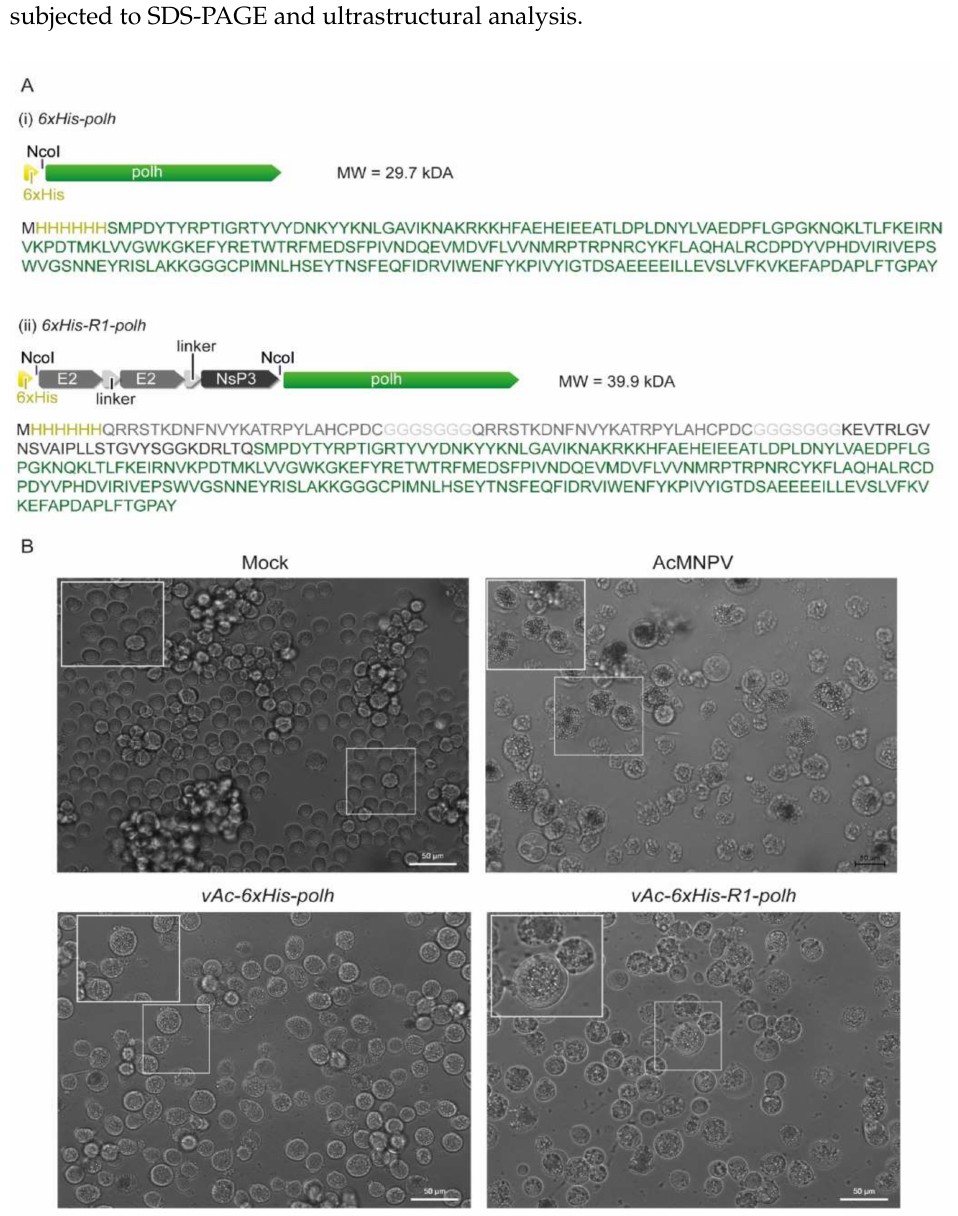
Figure 1. Schematic representation and light microscope of recombinants 6xHis-polh and 6xHis- R1-polh. ( A ) Schematic representation of modified polh gene cloned into pFastBac1 to generate 6xHis-polh and CHIKV multi-epitope gene (R1) fused at 5 (cid:48) region of polh (6xHis-R1-polh); ( B ) Sf9 cells at 72 h.p.i. with the respective second passage virus stock (m.o.i. of five): mock-infected cells, cells infected with vAc-6xHis-polh, vAc-polh-R1-6xHis, and AcMNPV. The insets show details of infected cells with the amorphous crystal that accumulate in nucleus of the infected